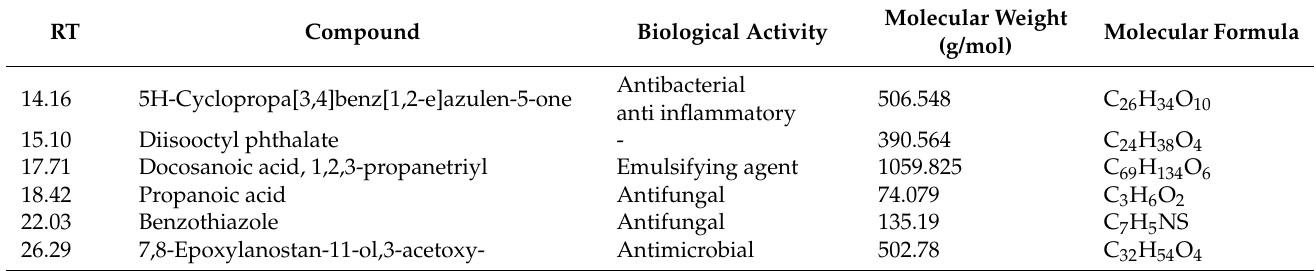
Table 3. List of antimicrobial compounds from ethyl acetate solvent fractions from fruiting body of G. lucidum using